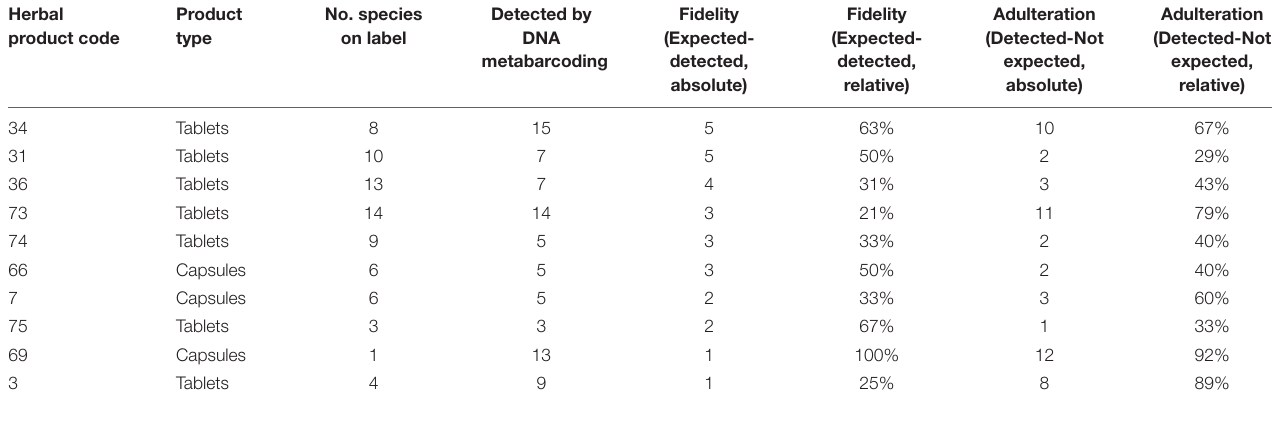
TABLE 2 | Top ten products with the highest fidelity and their level of adulteration. Herbal product